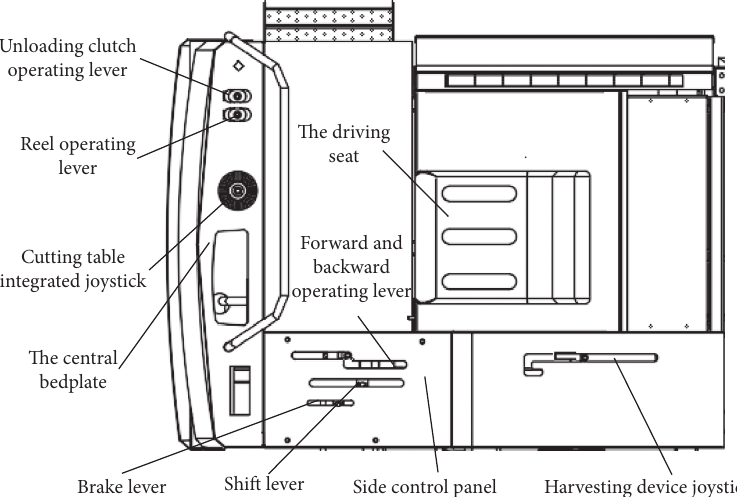
Figure 3: Top view of the combine harvester cab.